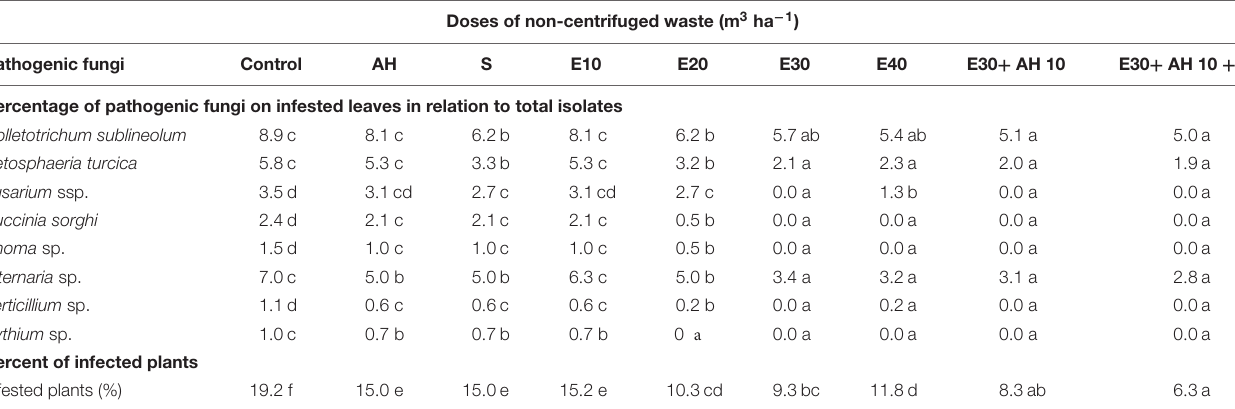
TABLE 4 | Species composition and percentage of pathogenic fungi on infested leaves in relation to total isolates and the percent of infected plants, as effected by sorghum plant fertilization with waste from a biomass biodigestion to methane (E), Apol-humus (AH) and Stymjod (S) in